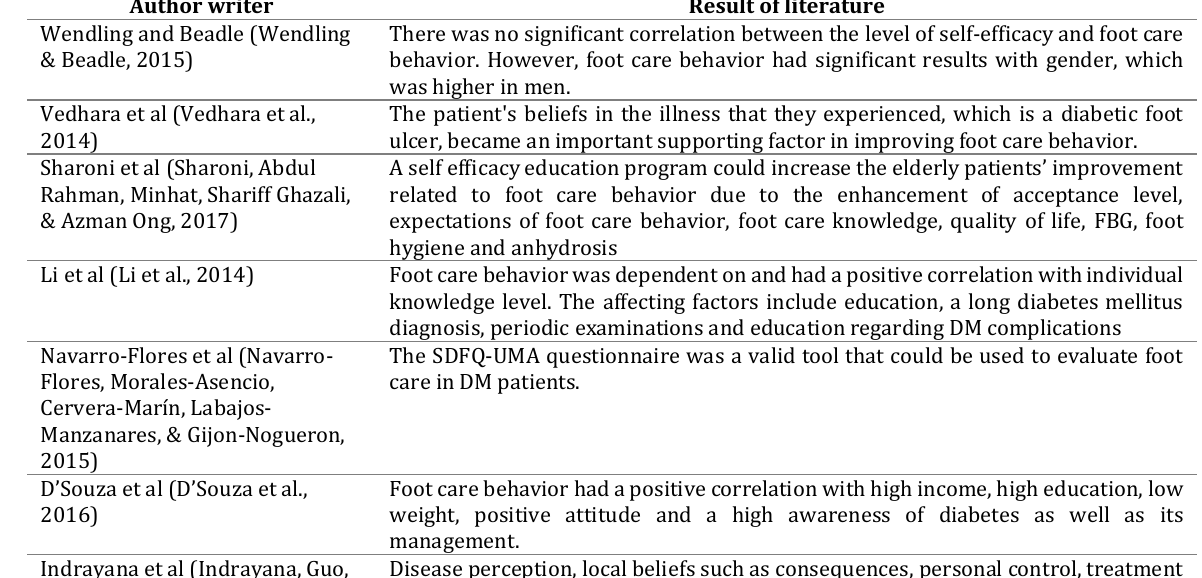
Table 1. Systematic Review of the Established